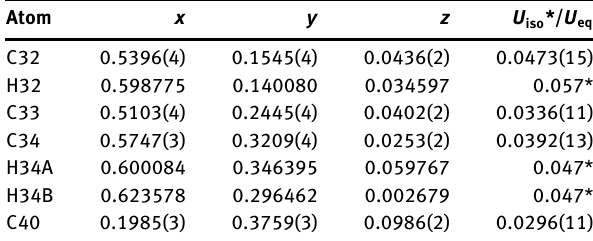
Table 2: Fractional atomic coordinates and isotropic or equivalent isotropic displacement parameters (Å 2